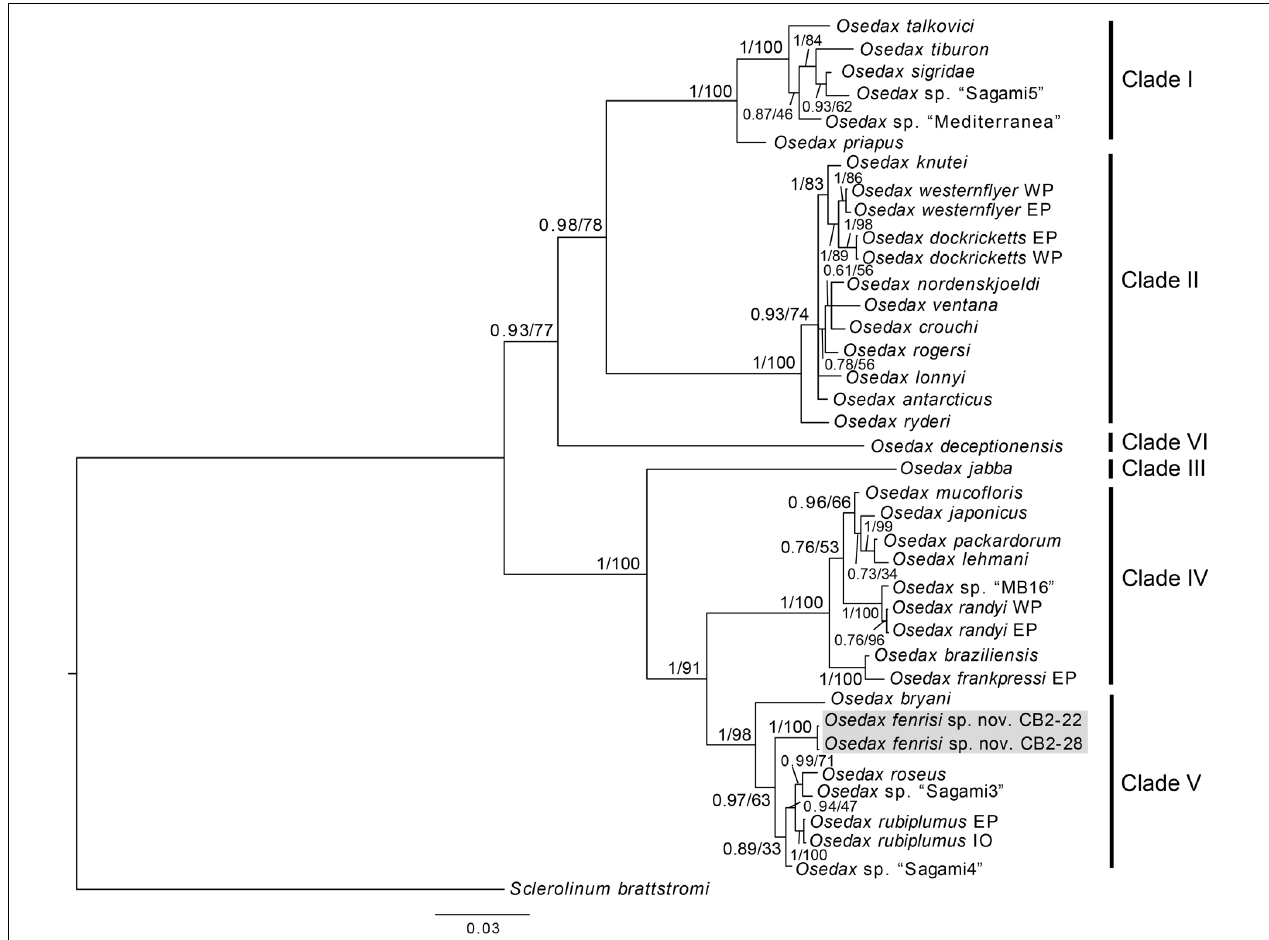
FIGURE 2 | Phylogenetic reconstruction based on the concatenated dataset of COI and 18S. The tree is the summary tree from the MrBayes analysis, and node support values are given as PP/BS. For nodes that were not recovered in the tree from the maximum likelihood analysis, support is denoted as a hyphen (-). Placeholder names for undescribed OTUs are shown in quotation marks, while for species with more than one specimen is included, the region of the specimens is indicated following the species name (EP, East Pacific; WP, West Pacific; At, Atlantic; IO, Indian